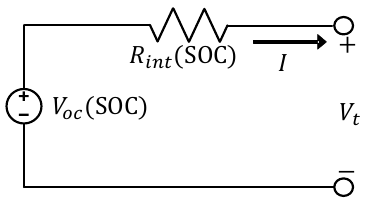
Figure 8. Internal resistance battery model.